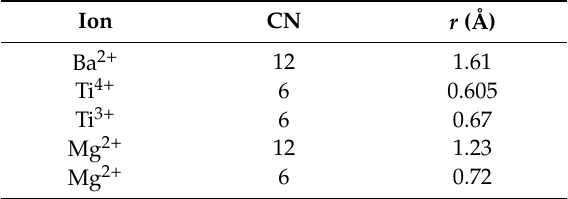
Table 1. Ionic radius as a function of coordinate number